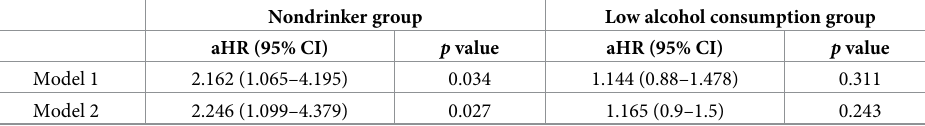
Model 1 was adjusted for all of the variables that were associated with metabolic disease, namely, age, gender, the